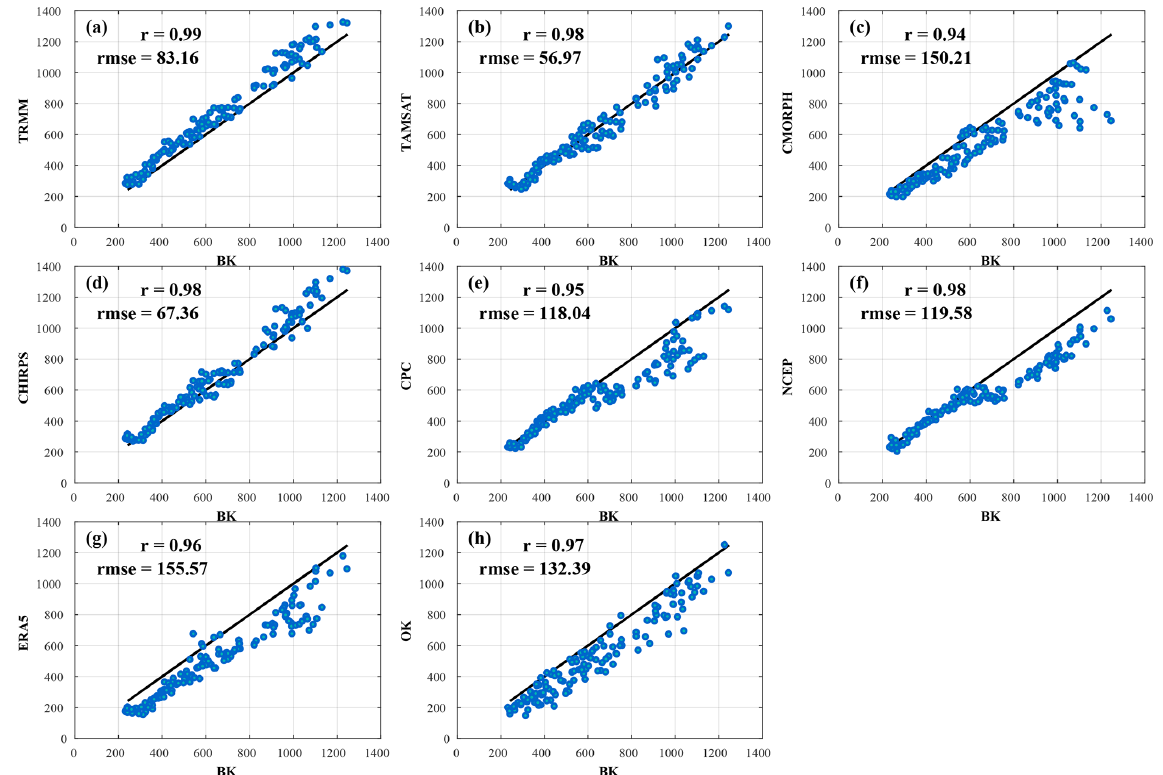
Figure 3. Scatter plots of cumulative seasonal rainfall from rain gauge BK versus (a) TRMM, (b) TAMSAT, (c) CMORPH, (d) CHIRPS, (e) CPC, (f) NCEP, (g) ERA5, and (h) OK. The RMSE and correlation scores are spatial and computed for the rainy season (June to October) over the 1998–2010 period. Details of the datasets are provided in Table 1.